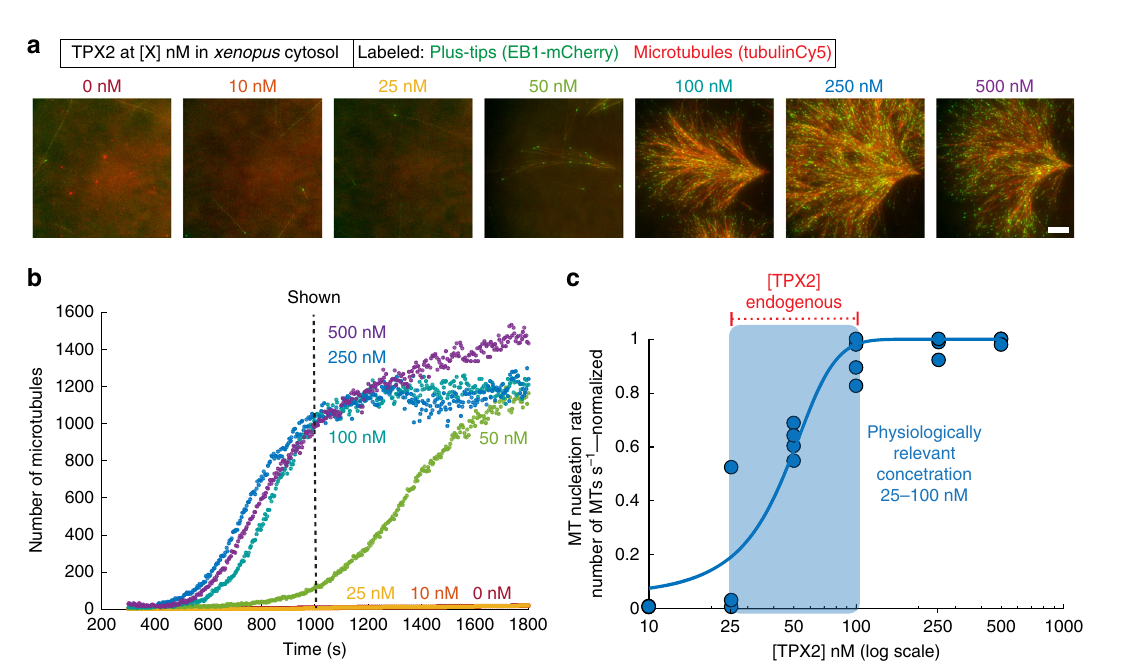
Fig. 2 TPX2 preferentially co-condenses with tubulin on MTs. a Experimental setup for b and c : non-phase-separated GFP-TPX2 (50 nM) and Alexa568- labeled tubulin mixed with Xenopus meiotic egg cytosol and imaged via oblique-TIRF microscopy. b GFP-TPX2 (green) localization to growing MT network imaged over time (minutes:seconds) in the cytosol (see Supplementary Movie 2), representative of three experimental replicates. Microtubules are labeled red and growing plus-tips are blue. All scale bars are 3 µ m, unless indicated. c GFP-TPX2 (green) - and Alexa568-labeled tubulin (red) colocalization in the cytosol treated with Nocodazole to prevent MT polymerization, representative of fi ve experimental replicates. Images taken 10 min into reaction (see Supplementary Movie 3). Scale bar is 3 µ m. TPX2 was 50 nM and tubulin was 2 µ M. d TIRF images (contrast-optimized), representative of four experimental replicates, and e quanti fi cation of GFP-TPX2 (green) and Cy5-labeled tubulin (magenta) (at indicated concentrations, both proteins equimolar) localized to pre-formed microtubules (Alexa568-labeled, GMPCPP stabilized — red) and spun down onto coverslips, fi xed, and imaged; scale bar, 3 µ m. f Oblique-TIRF images of only Cy5-labeled tubulin (magenta) condensed with GFP-TPX2 (not shown) either in solution (top panel) or on a pre- formed MT (lower panel — MT not shown) at concentrations shown. Images displayed at matched brightness and contrast. Enhanced contrast of 10 nM and 25 nM images shown is shown in the box. Scale bar, 2 µ m. g Quanti fi cation of relative tubulin signal from TPX2-tubulin co-condensates in solution (blue curve) and on microtubules (purple curve) at concentrations shown in e . Mean (points) and SEM (error bars) of three replicate experiments (error bars) shown, n of microtubules per condition are: 145, 216, 114, 217, 243, 335, 309, and 309 for 1, 2.5, 5, 10, 25, 50, 100, and 250 nM [TPX2/TB], respectively; n of condensates per condition are: 280, 225, 266, and 282 for 10, 25, 50, 100, and 250 nM [TPX2/TB], respectively. Endogenous concentration range of TPX2 ( q = 25 – 100 nM) indicated. h Schematic of experimental setup — live observation of TPX2 (green) and soluble tubulin (magenta) localization to a stable microtubule (red) attached to a coverslip-bottomed well. i TIRF images of a time series of GFP-TPX2 (green) and soluble Cy5-labeled tubulin (magenta) localization to a GMPCPP-stabilized Alexa568-labeled microtubule seed (red) (see Supplementary Movie 4). Images are contrast enhanced to show early non-association events and are representative of three experimental replicates. Arrowheads indicate fusion of two condensates. Time in minutes:seconds, 00:00 corresponds to addition of TPX2 into the well. Scale bar, 2 µ m. Source data are provided as a Source Data fi le.